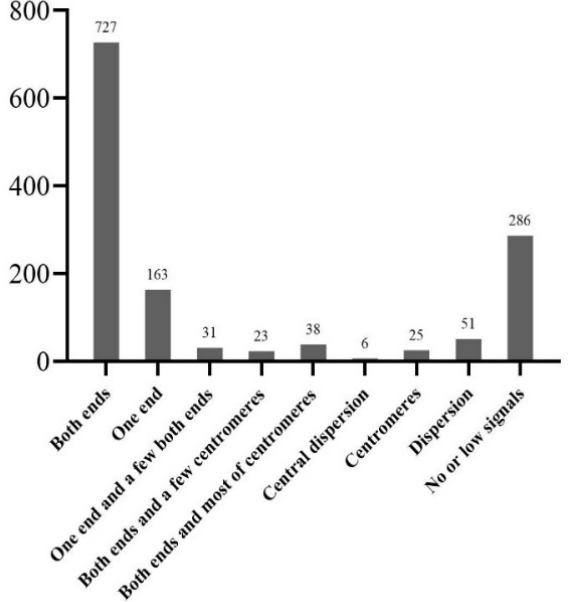
Figure 4. The statistic result of various types of the probe sequence.